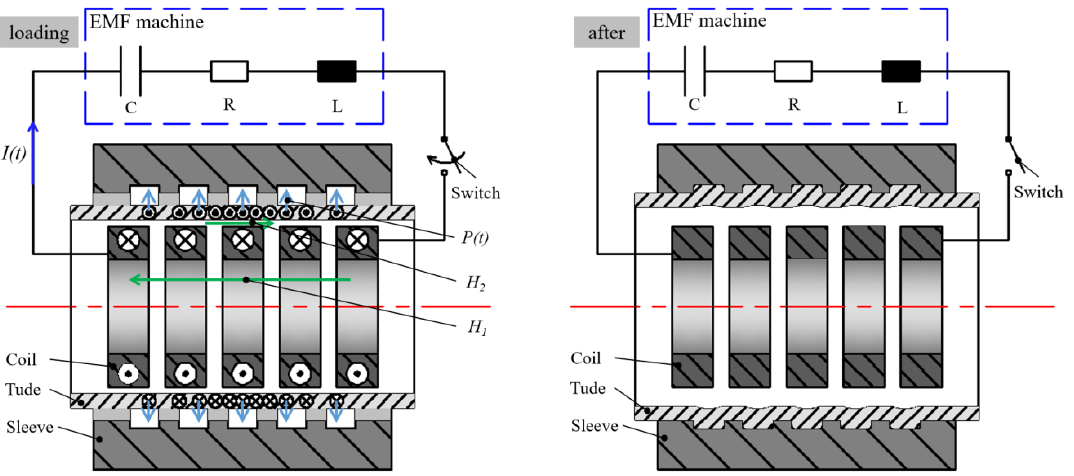
Figure 1. Principle of EMP connection technology for pipe joints.